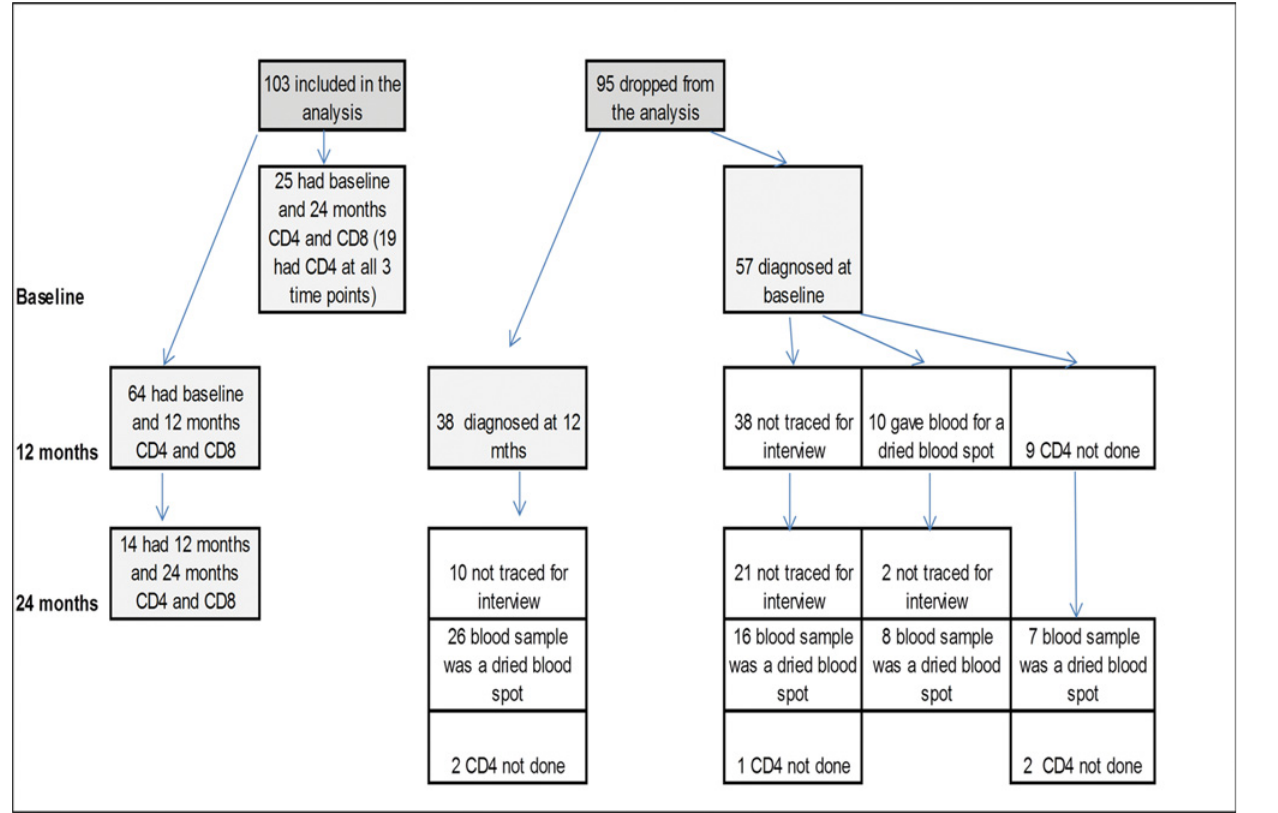
Fig 1. Flow Chart of Follow Up and Loss to Follow